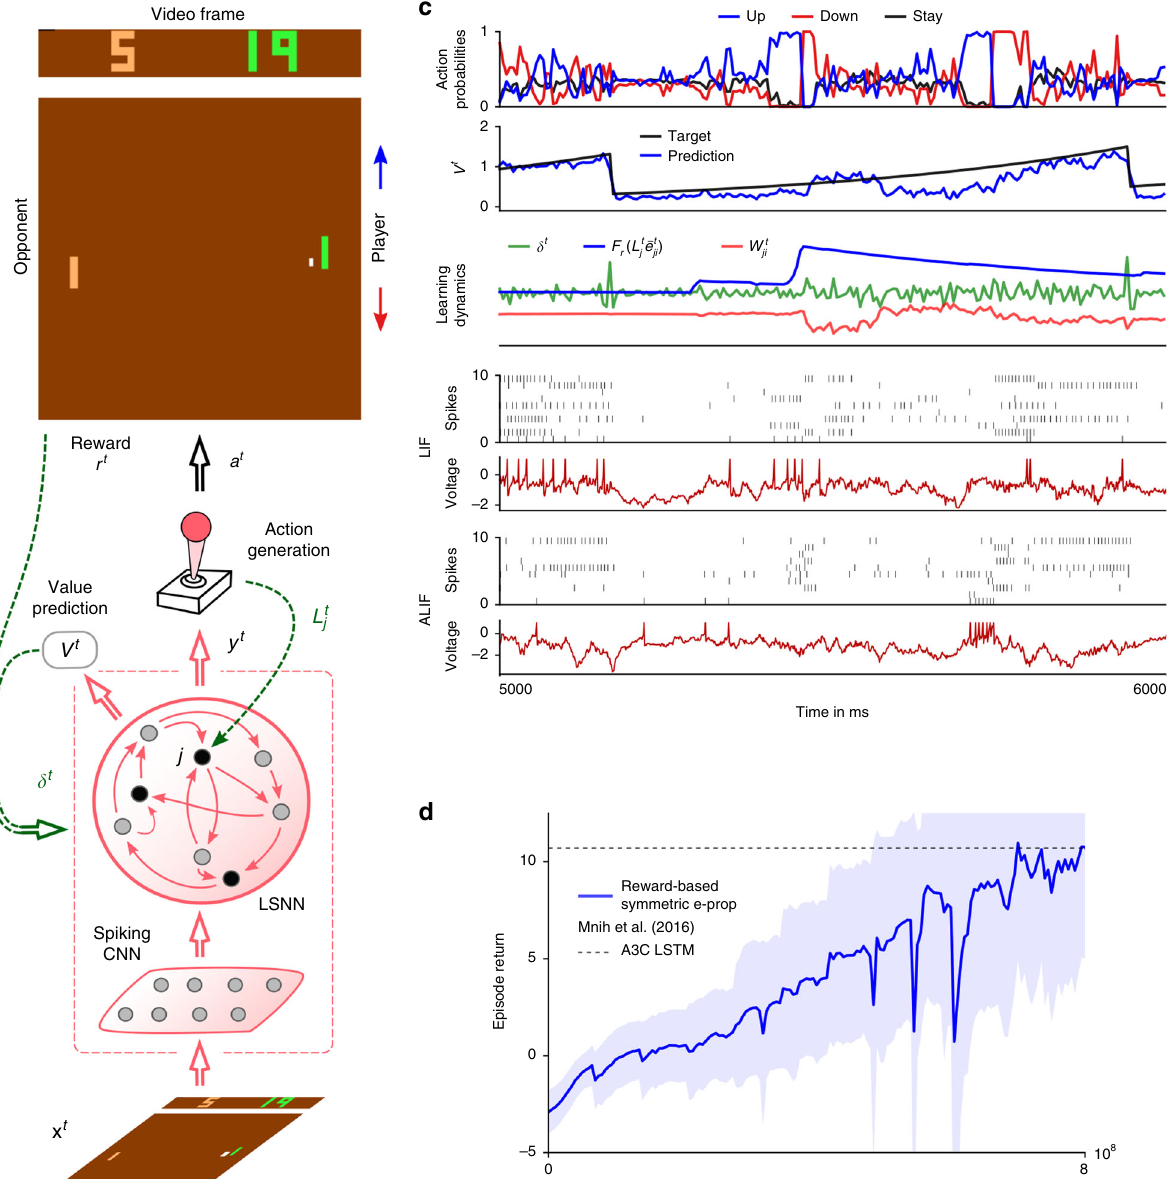
Fig. 4 Application of e-prop to the Atari game Pong. a Here, the player (green paddle) has to outplay the opponent (light brown). A reward is acquired when the opponent cannot bounce back the ball (a small white square). To achieve this, the agent has to learn to hit the ball also with the edges of his paddle, which causes a less predictable trajectory. b The agent is realized by an LSNN. The pixels of the current video frame of the game are provided as input. During processing of the stream of video frames by the LSNN, actions are generated by the stochastic policy in an online manner. At the same time, future rewards are predicted. The current error in prediction is fed back both to the LSNN and the spiking CNN that preprocesses the frames. c Sample trial of the LSNN after learning with reward-based e-prop. From top to bottom: probabilities of stochastic actions, prediction of future rewards, learning dynamics of a random synapse (arbitrary units), spiking activity of 10 out of 240 sample LIF neurons and 10 out of 160 sample ALIF neurons, and membrane potentials (more precisely: v t j (cid:4) A t j ) for the two sample neurons j at the bottom of the spike raster above. d Learning progress of the LSNN trained with reward-based e-prop, reported as the sum of collected rewards during an episode. The learning curve is averaged over fi ve different runs and the shaded area represents the standard deviation. More information about the comparison between our results and A3C are given in Supplementary Note